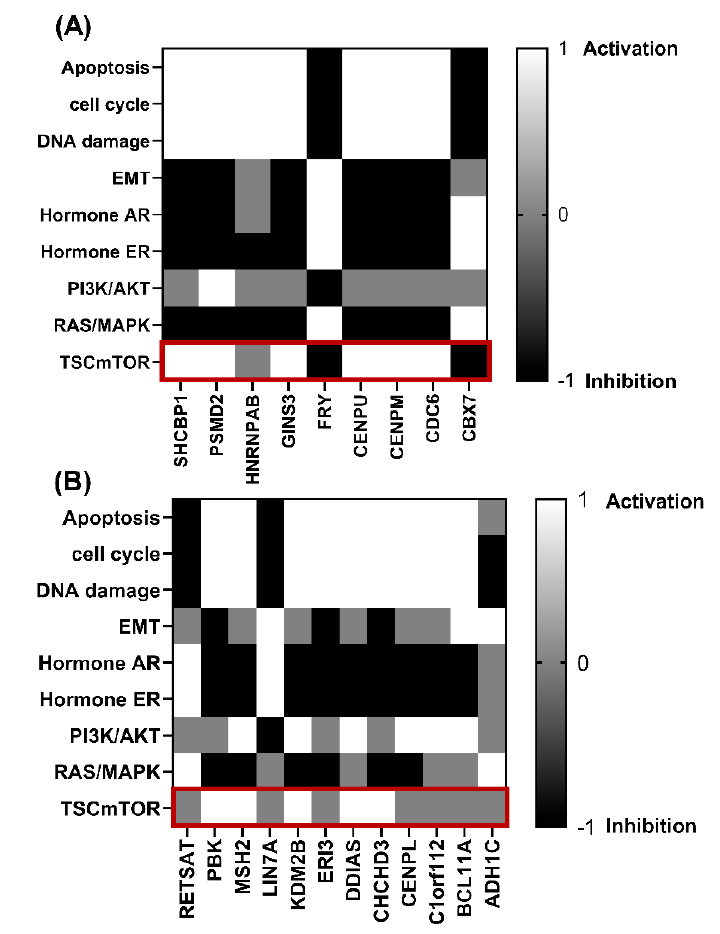
Figure 5. ( A ) Heat map shows the activated and inhibited pathways based on genes that significantly correlate with TUBB in ER α –positive breast cancer patients; ( B ) Heat map shows the activated and inhibited pathways based on genes that significantly correlate with TUBB in ER α –negative breast cancer patients.